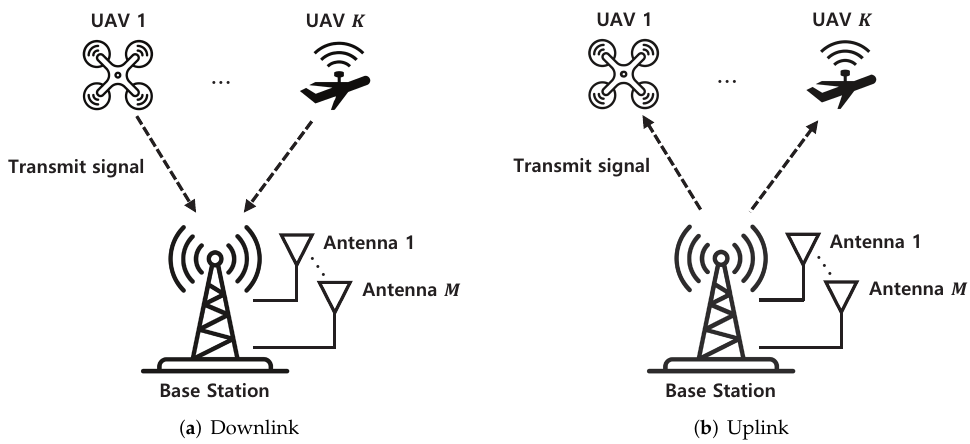
Figure 1. System models for UAV wireless